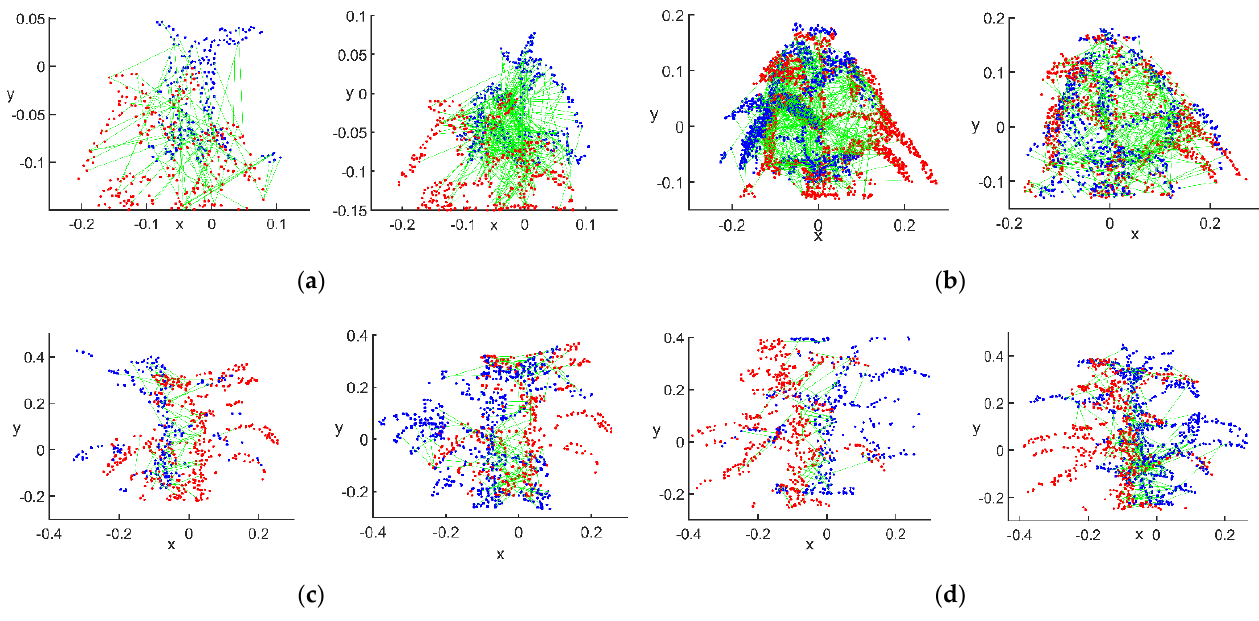
Figure 10. Matching effect after filtering for rigid invariant constraints: ( a ) flowering stage; ( b ) podding stage; ( c ) filling stage; ( d ) mature stage. After filtering by the rigid invariance constraint, there were 116 matching point pairs between the main view and view 1 and 101 matching point pairs between the main view and view 2 at the flowering stage. There were 350 matching point pairs between main view and view 1 and 335 matching point pairs between the main view and view 2 at podding stage. There were 101 matching point pairs between main view and view 1 and 377 matching point pairs between main view and view 2 at the filling stage. There were 190 matching point pairs between the main view and view 1 and 385 matching point